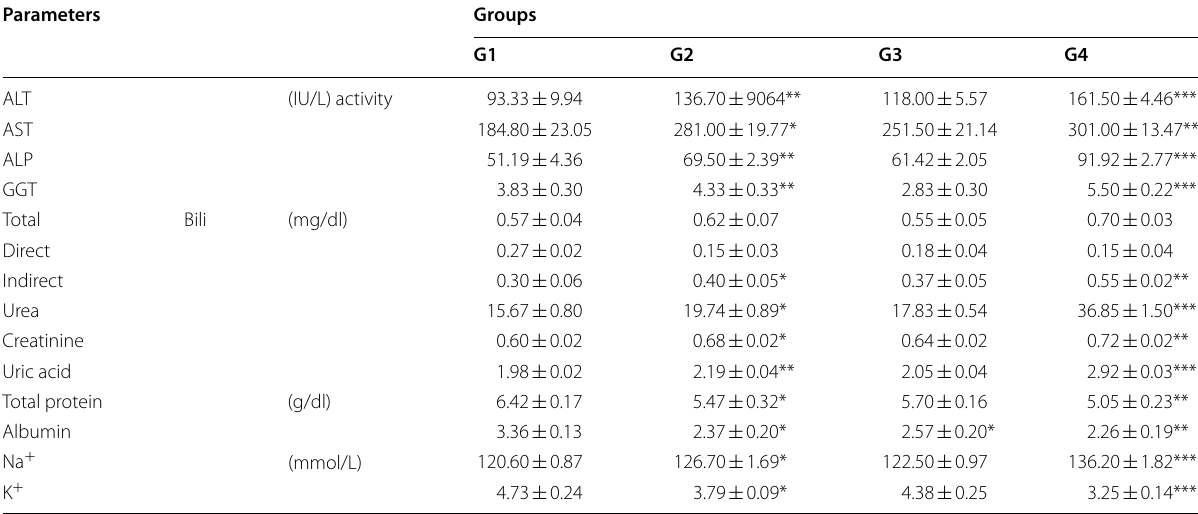
Table 2 The influence of Tamiflu on the serum markers of hepatic/renal toxicities of the various treated groups compared to that of the control group